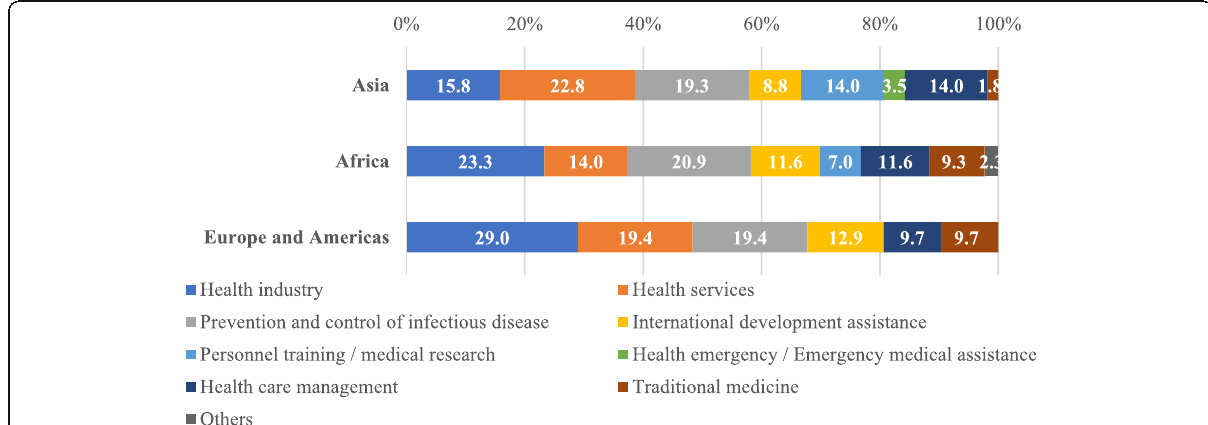
Fig. 1 Areas of interest to cooperate with China in BRHC perceived by respondents from the countries of Asia ( n = 24), Africa ( n = 19), Europe and Americas ( n = 15)